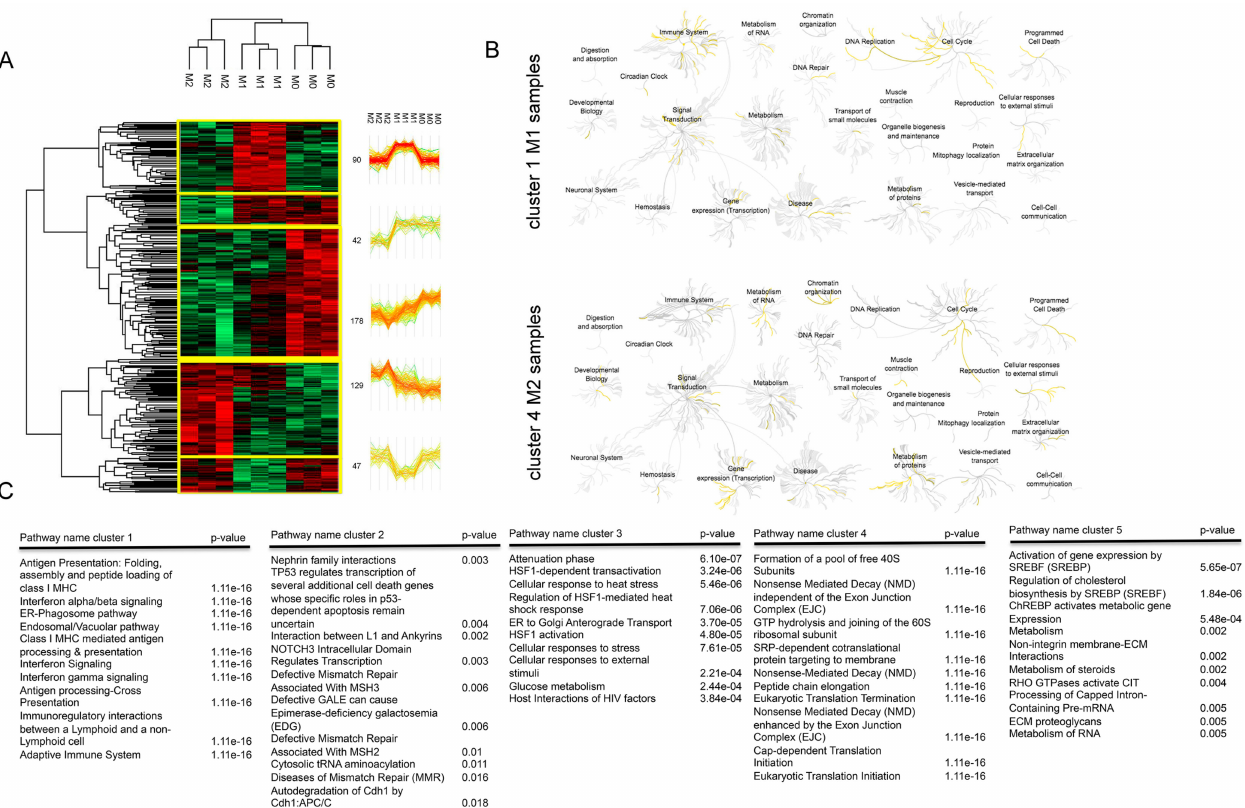
Figure 3. Mass spectrometry analysis of microglia cells. ( A ) Data from three independent biological experiments were combined and analyzed with MaxQuant. Hierarchical heatmap clusters obtained by Perseus of significant proteins from ANOVA across the three groups. Green color corresponds to a decreased expression level and red color to an increased expression level. Profile plots of five clusters showing distinct behavior with respect to the three groups are shown and highlighted in yellow in the heatmap. ( B ) Top 10 enriched networks identified by functional analysis of di ff erentially expressed proteins and ranked according to p -value. Data were analyzed using REACTOME. ( C ) Genome-wide overview pathway analysis of cluster 1 and cluster 4 performed using REACTOME. The yellow color code denotes over-representation of that